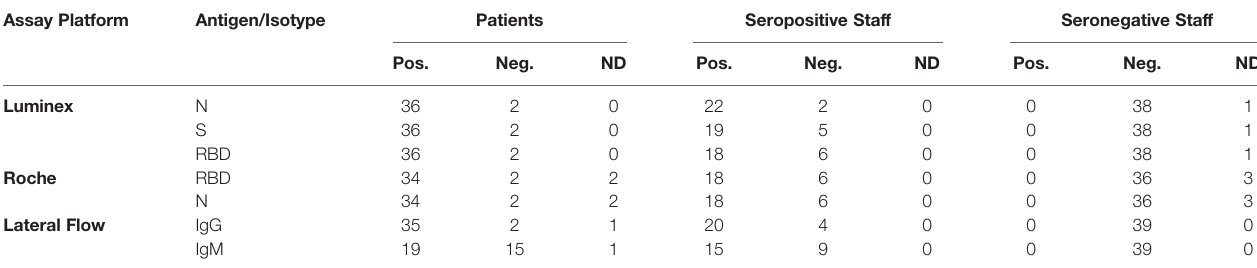
TABLE 2 | Cohorts. Classi fi cation of participants according to the serological screening of the sera by the ECLIA, multiplex Micros-sphere, and lateral fl ow assays. Assay